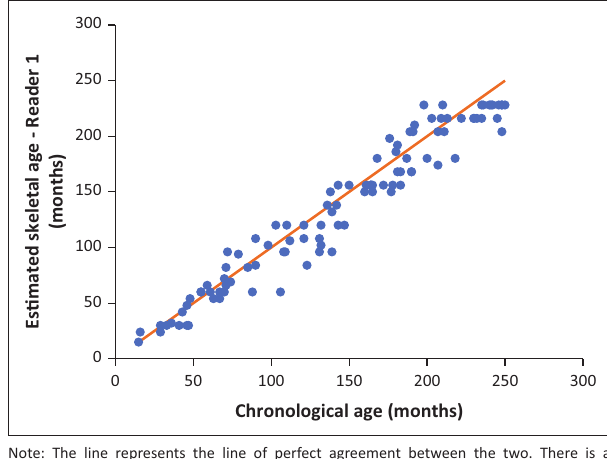
FIGURE 4: Scatterplot of the skeletal age estimated by Reader 1 (y-axis) and the chronological age (x-axis) in months (Pearson’s correlation coefficient = 0.973).